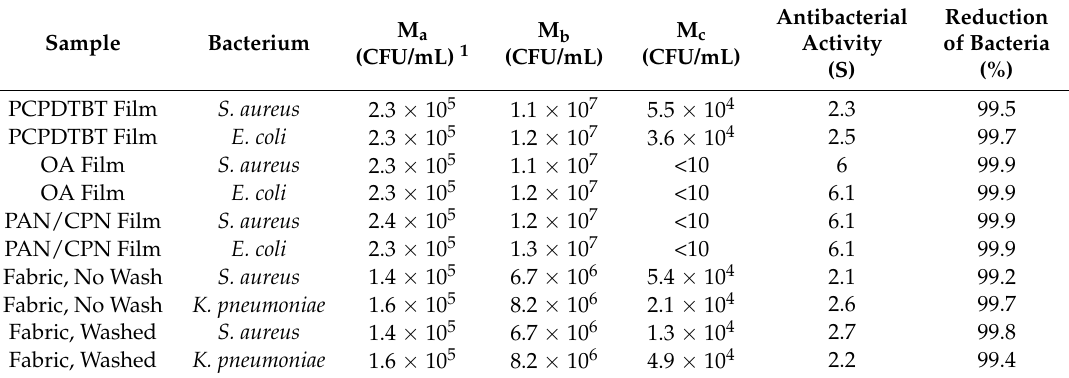
Table 2. Antibacterial activity and reduction in bacterial concentrations on the surfaces of Petri dishes Figure 4. FT-IR spectra of a pristine PAN and a PAN/CPN nanocomposite films. coated with PCPDTBT, OA, and PCPDTBT/CPN nanocomposite films, and on fabrics before and after washing.